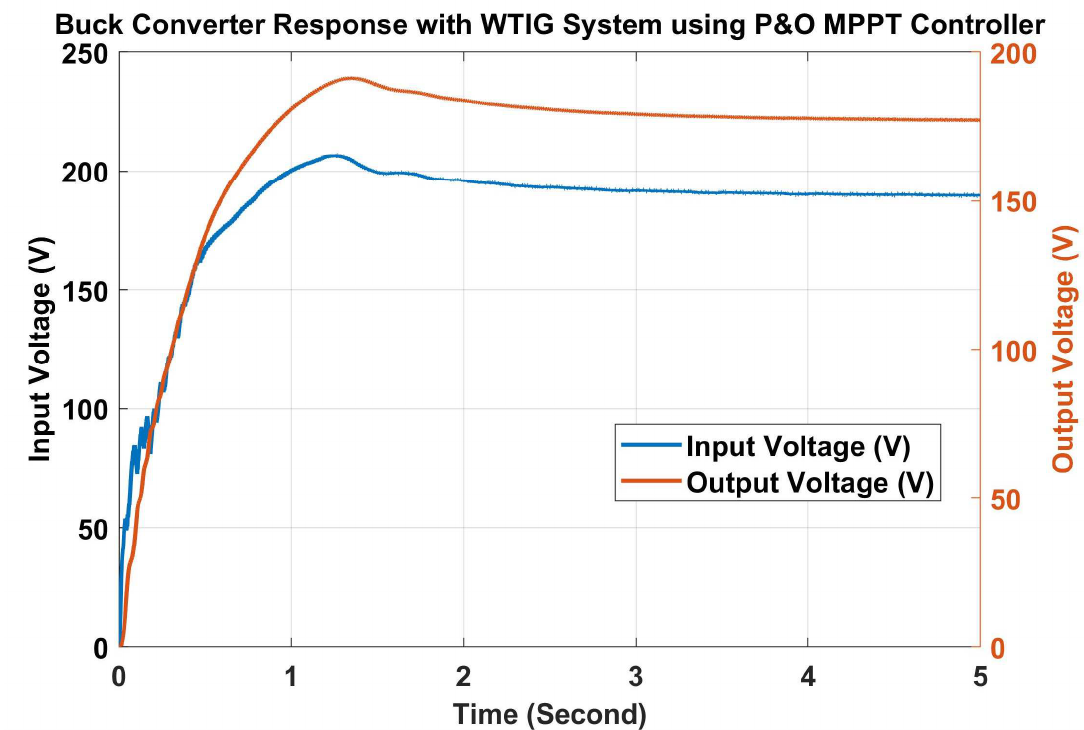
Figure 7. Input and Output Power of Buck Converter with WTIG System and P-&-O MPPT.